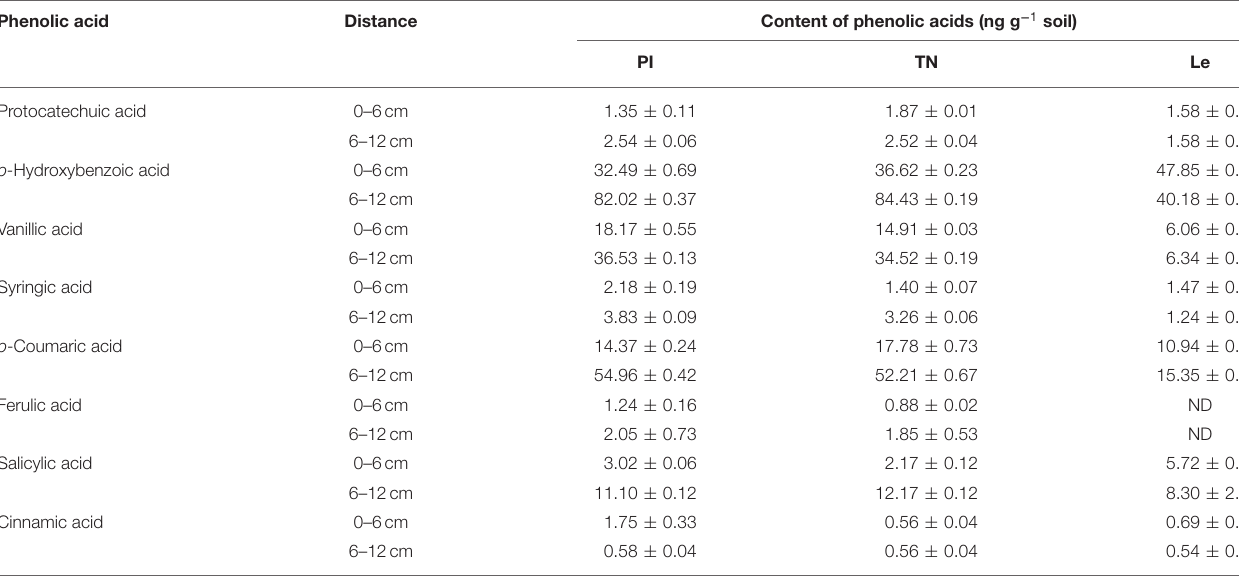
TABLE 2 | The content of eight phenolic acids in two soil circles of different allelopathic rice